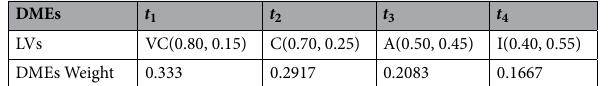
Table 4. DMEs’ weights for SIBO